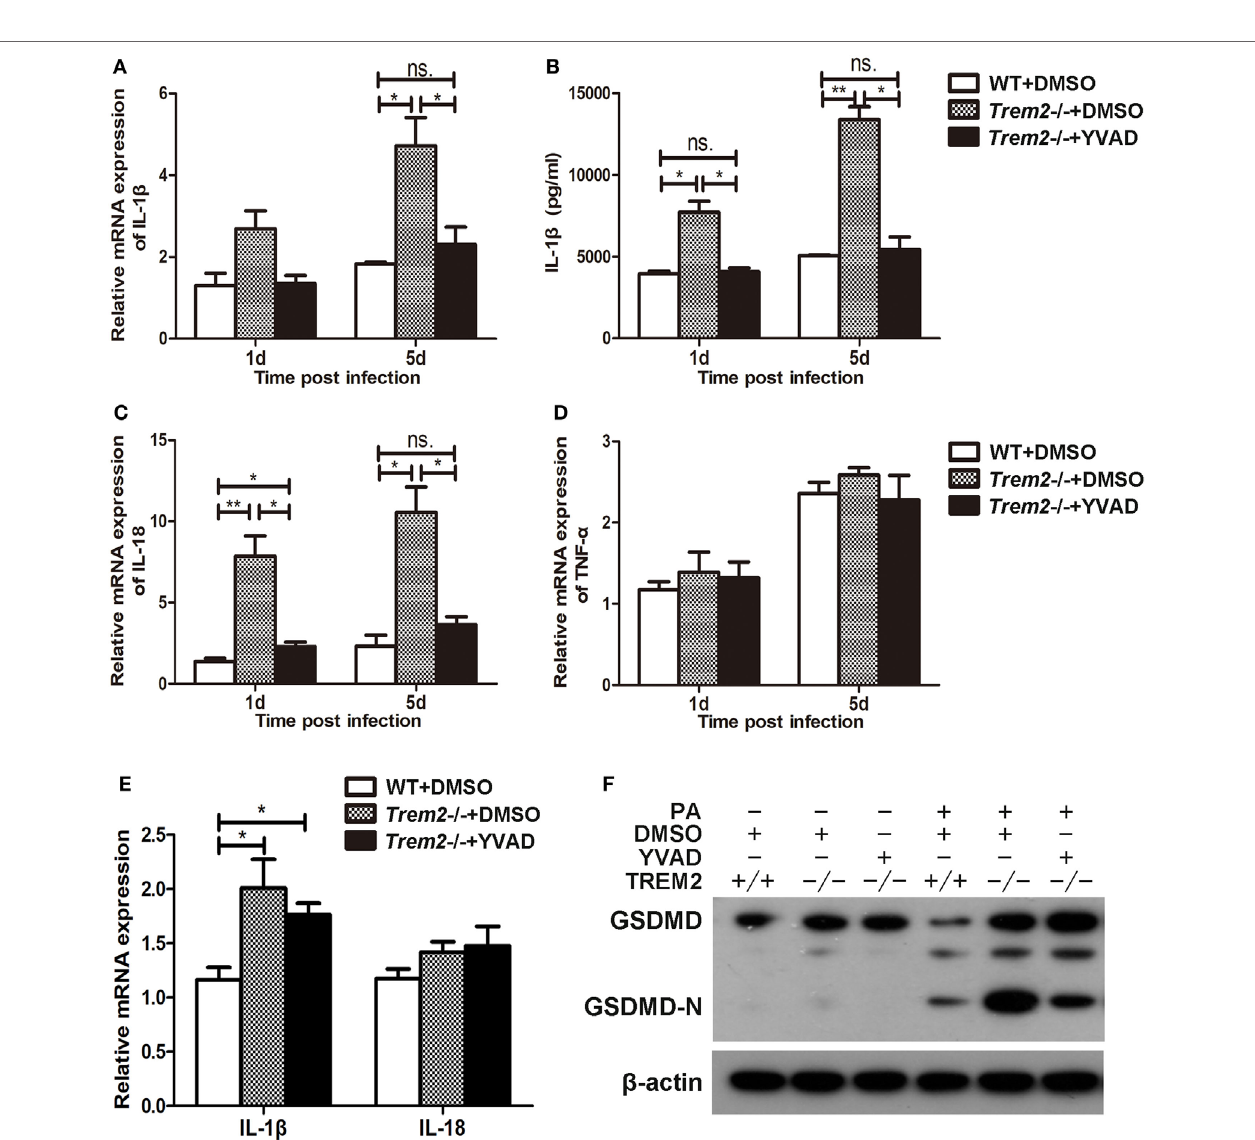
FigUre 6 | Triggering receptors expressed on myeloid cells 2 (TREM-2) decreased corneal inflammation and bacterial load in Pseudomonas aeruginosa keratitis via inhibiting caspase-1. Wild type (WT) mice were subconjunctivally injected with the vehicle control (DMSO) and Trem2 − / − mice were subconjunctivally injected with the vehicle control (DMSO) or caspase-1 inhibitor YVAD, and then infected with P. aeruginosa routinely. (a) Clinical score was recorded for each cornea at 1 and 5 days after infection. (B) Representative photographs of infected eyes in YVAD- versus DMSO-treated Trem2 − / − mice as well as DMSO-treated WT mice were taken at 1 and 5 days after infection. (c) Bacterial load in the infected corneas was examined by plate count in YVAD- versus DMSO-treated Trem2 − / − corneas as well as DMSO-treated WT corneas at 1 and 5 days after infection. (D) Hematoxylin and eosin staining was used to examine the histopathology of infected eyes in DMSO-treated WT (left), DMSO-treated Trem 2 − / − (middle), and YVAD-treated Trem 2 − / − (right) mice at 1 and 5 days after infection. Magnification = 100 × . Data are the mean ± SEM and represent three individual experiments each with 10 mice per group (a,B) or five mice per group (c,D) . * P < 0.05; ** P < 0.01; *** P <